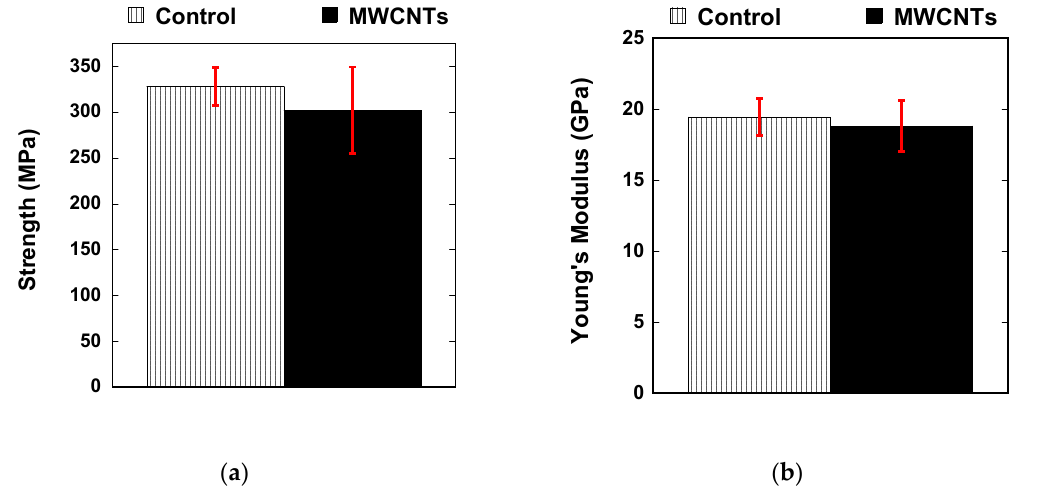
Figure 2. Mechanical properties of the laminates with and without carbon nanotubes showing ( a ) ultimate strength and ( b ) Young’s modulus for the control specimens and specimens with integrated MWCNTs.